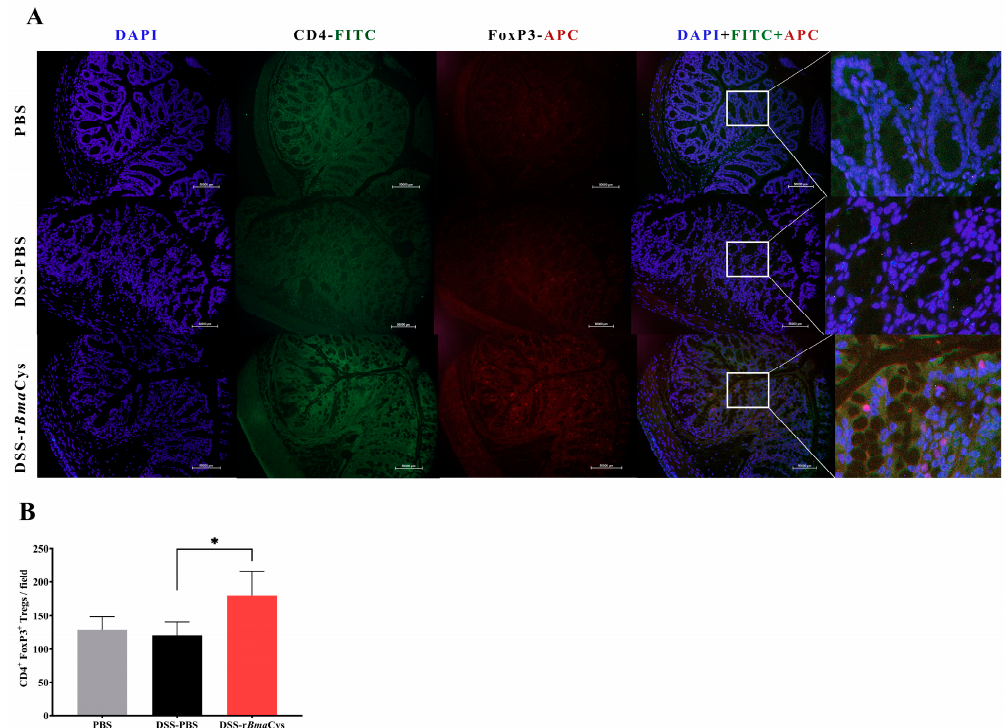
Figure 4. The number of Tregs were increased in the colon tissue of DSS - r Bma Cys-treated mice. Sections of the colon tissue were stained with DAPI, mouse anti-CD4 (FITC), and anti-FoxP3 (APC) antibodies. ( A ) Representative stained section from each group (200× magnification). ( B ) Total number of CD4 + FoxP3 + Tregs were counted in four fields (at 200×) and are presented as mean ± S.D. number of Tregs in the colon tissue section for each group. n = 10 mice per group, except DSS-PBS group which had 8 mice. * P < 0.05 compared to DSS-PBS group as determined using one-way ANOVA followed by Tukey’s posthoc test.